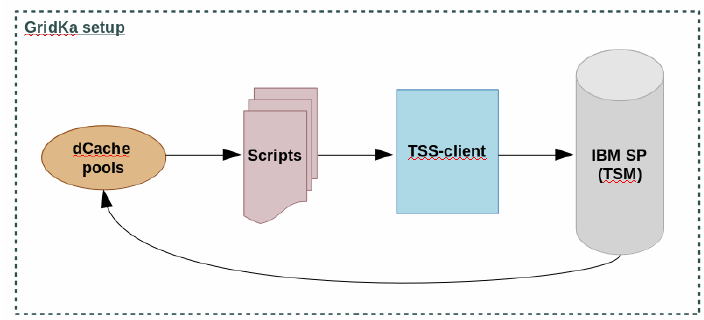
Figure 1: GridKa storage system: Interaction between dCache pools and IBM SP